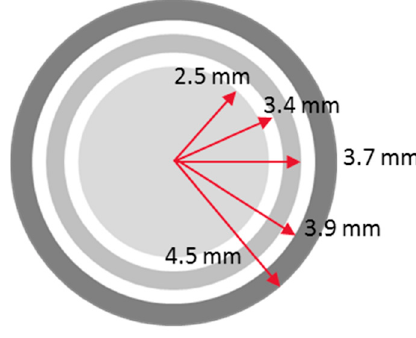
Figure 7. Specific dimensions of the electrodes.